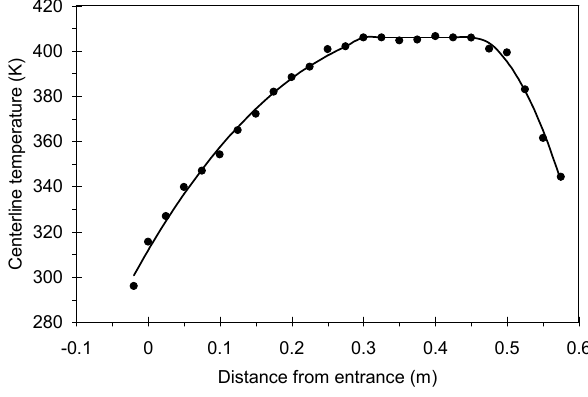
Figure 1. Temperature profile along the axis of the heating section at a flow rate of 1.15 L Fig. 1. Temperature profile along the axis of the heating section at min -1 . Lines are fitted to describe the temperature profile in the TD for the aerosol dynamics a flow rate of 1.15Lmin − 1 . Lines are fitted to describe the temper- model. ature profile in the TD for the aerosol dynamics